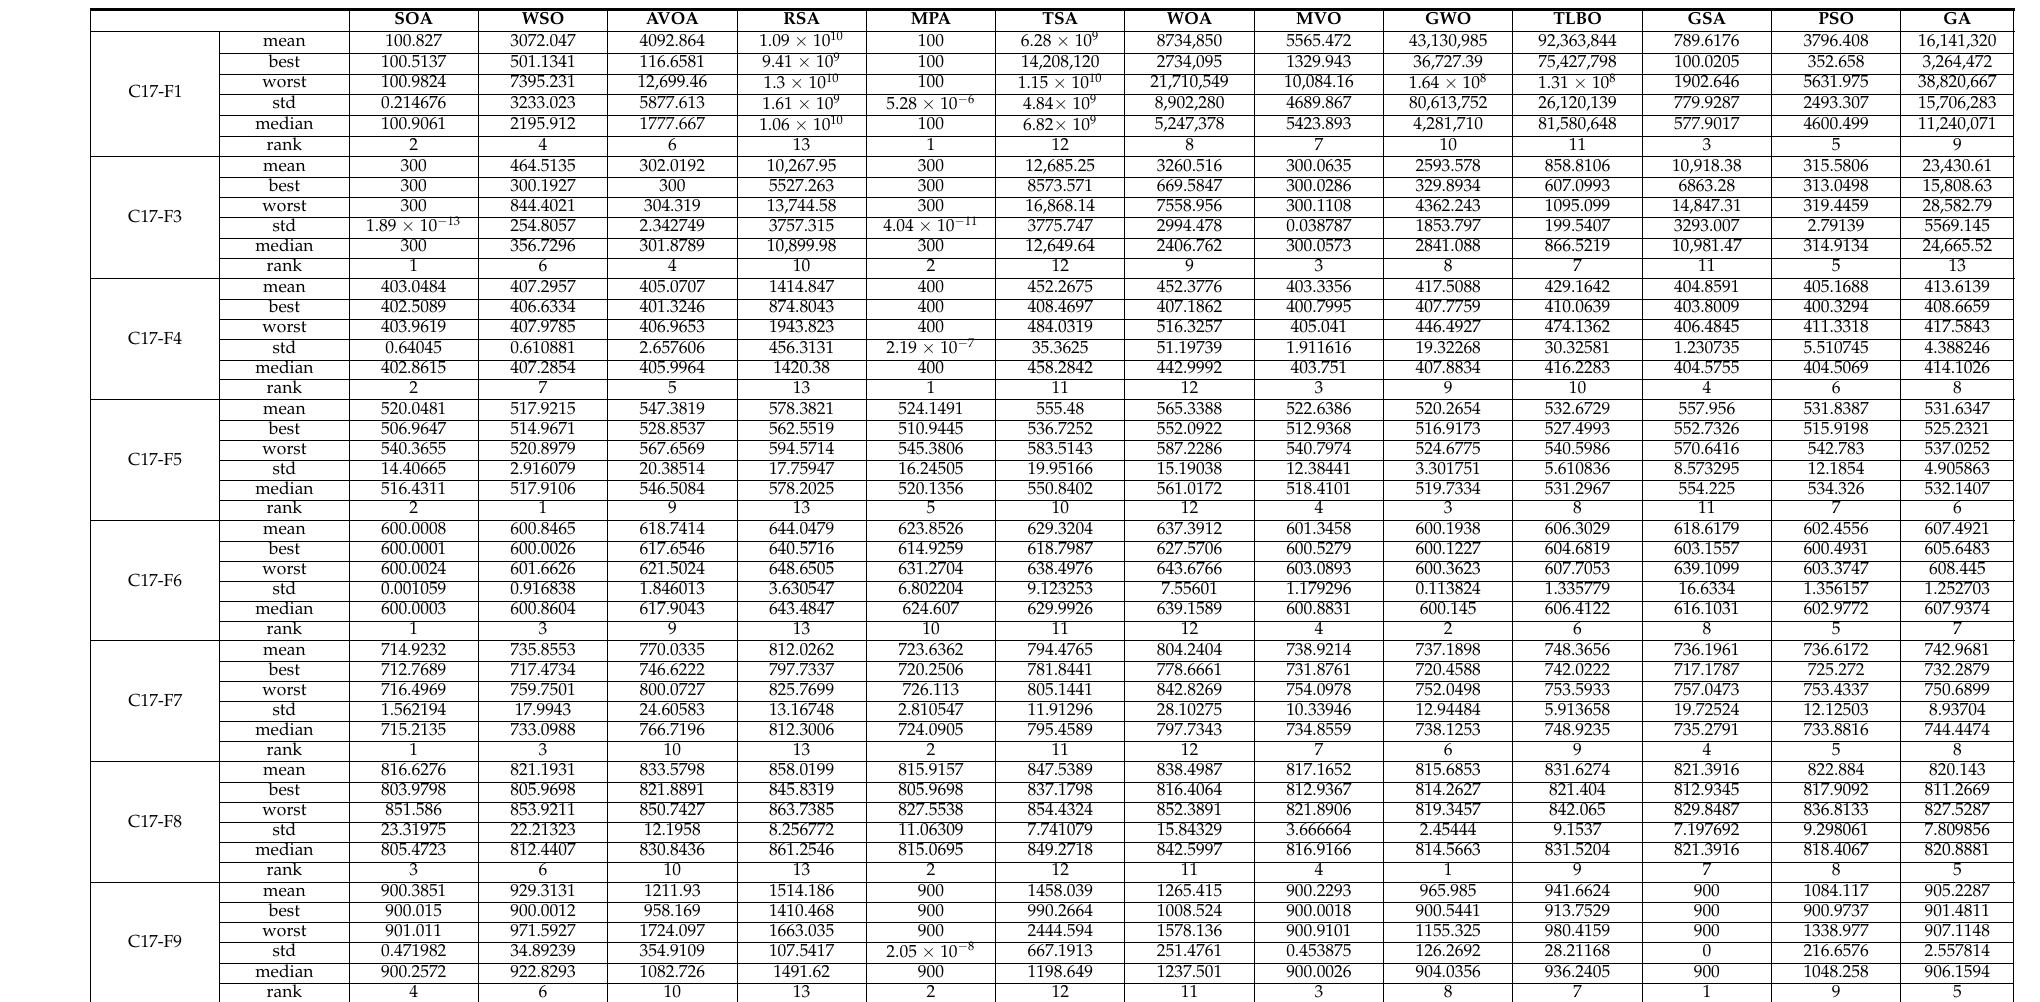
Table 2. Optimization results of the CEC 2017 test suite (for the dimension d =